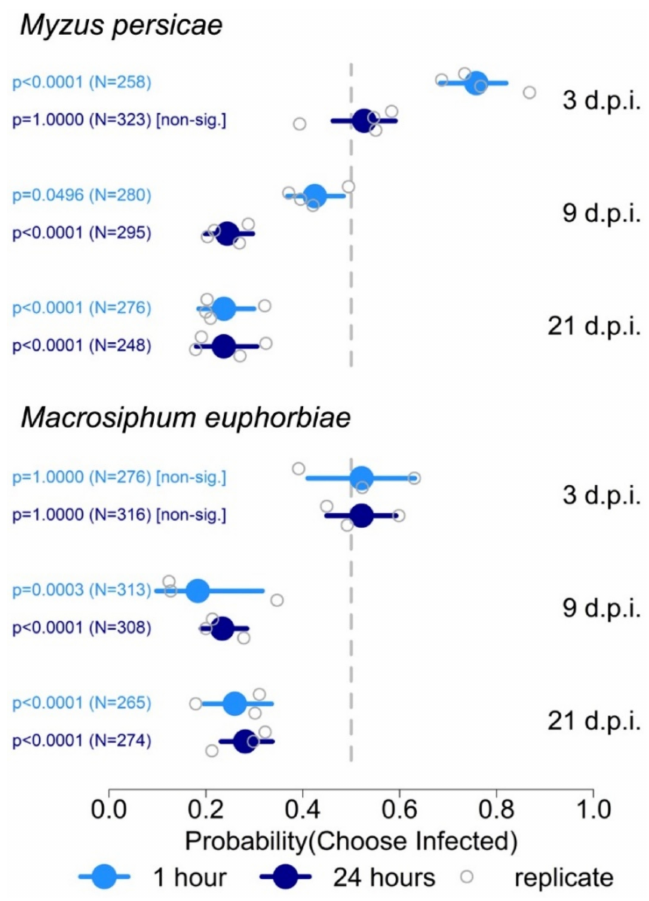
Figure 1. Summary of free-choice aphid preference assays to determine the likelihood of settling by aphids ( Myzus persicae and Macrosiphum euphorbiae ) on mock-inoculated tomato plants or plants